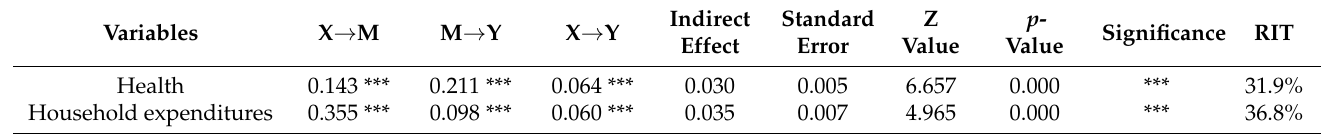
Table 10. Mediation Analysis.